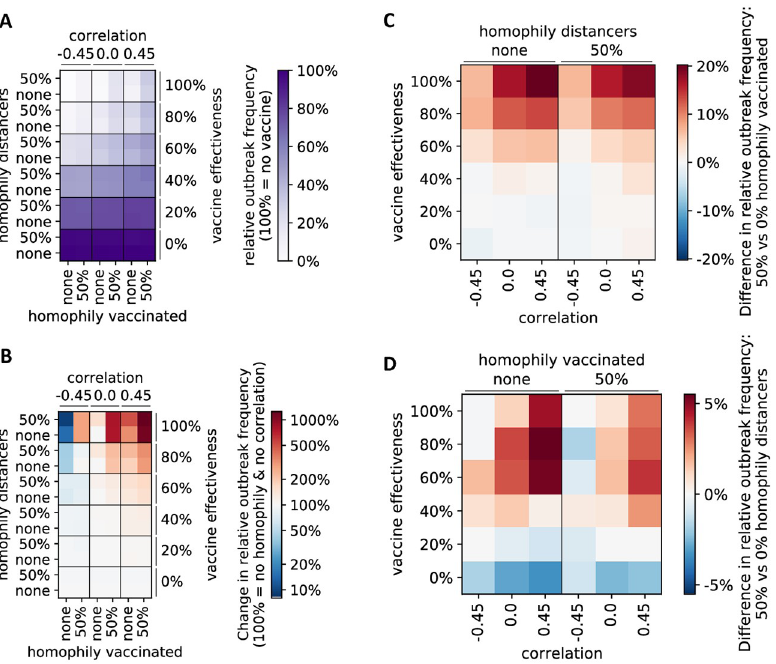
Fig 3. Effect of homophily and correlation of opinions on outbreak frequency. (A) The relative outbreak frequency is compared for different scenarios with respect to homophily and correlation of those who vaccinate and those who distance, and for different levels of vaccine effectiveness. Reference level for comparisons is a vaccine with 0% effectiveness and no homophily nor correlation of vaccinated and distancers. This reference level is set to 100%. (B) For each level of vaccine effectiveness, the change in relative outbreak frequency is compared to the homogeneous case of no homophily and no correlation, which is set to 100%, respectively. (C-D) Absolute difference in relative outbreak frequency (from A) when comparing physical interaction networks where (C) vaccinated, (D) distancers cluster (homophily = 50%) versus networks without homophily.